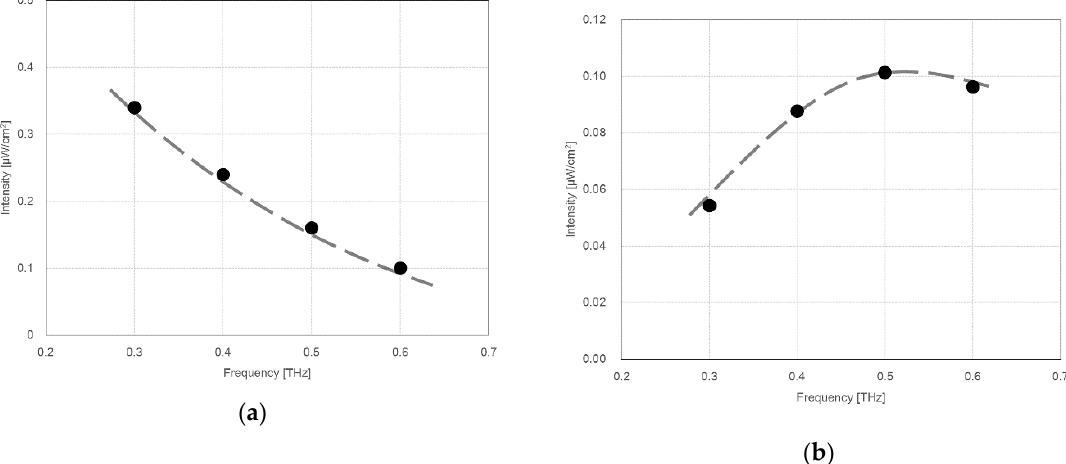
Figure 2. The frequency dependence on the irradiation intensity inside the culture well (a) and 96-well plate (b). ( a ) The irradiated THz wave covered the well through an aluminum waveguide. The intensity was less than 1 μ W/cm 2 including coupling and propagating loss by the waveguide and an absorption loss by the bottom of the cell. ( b ) The irradiated THz wave covered all of the 96-well plate through free space with the intensity approximately 0.1 μ W/cm 2 , including an absorption loss by the bottom of the well.